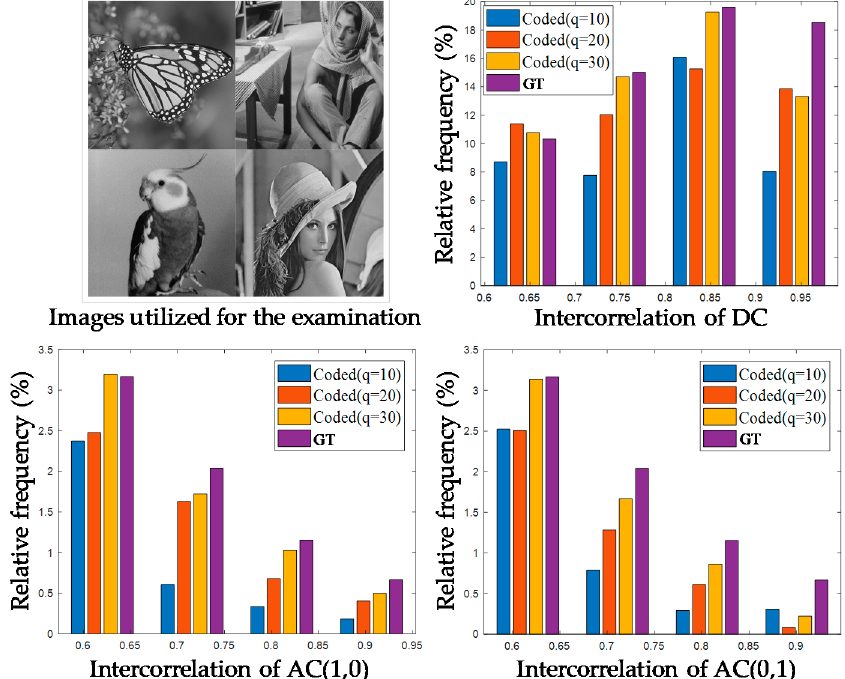
Figure 1. Intercorrelation distribution according to the compression level.